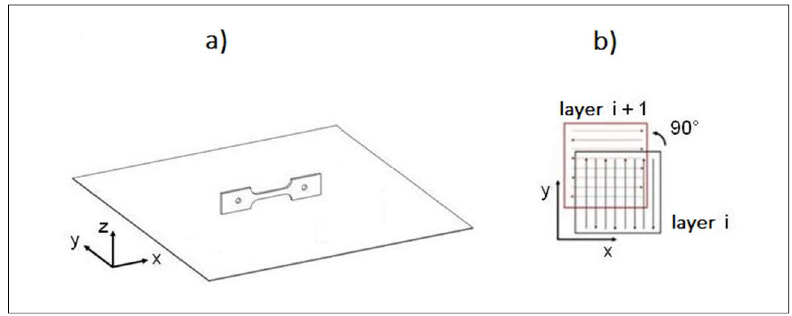
Figure 3. Specimens specification: ( a ) Typology with respect to the process plane; ( b ) Pattern of scanning line (snake x - y type) [28].